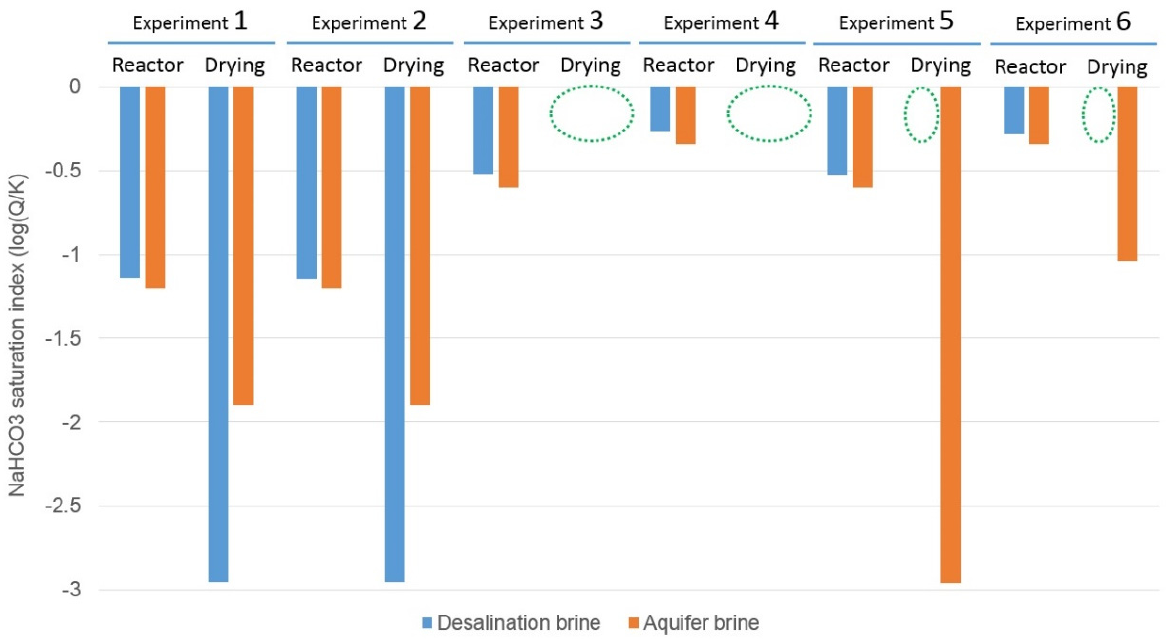
Figure 4. Geochemical modeling of the experiments indicating the saturation index of NaHCO 3 .